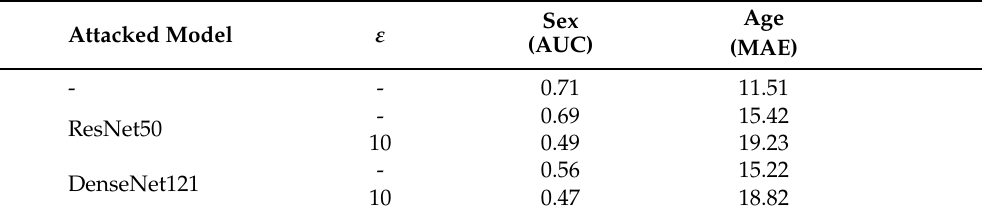
Table 9. Performance of the auxiliary models for predicting patient sex and age from X-ray images. We compare the predictions on original images, and images reconstructed from local ResNet50 and DenseNet121 models in the non-private and private setting with ε = 10. Images reconstructed from private models leaked no usable information about the selected